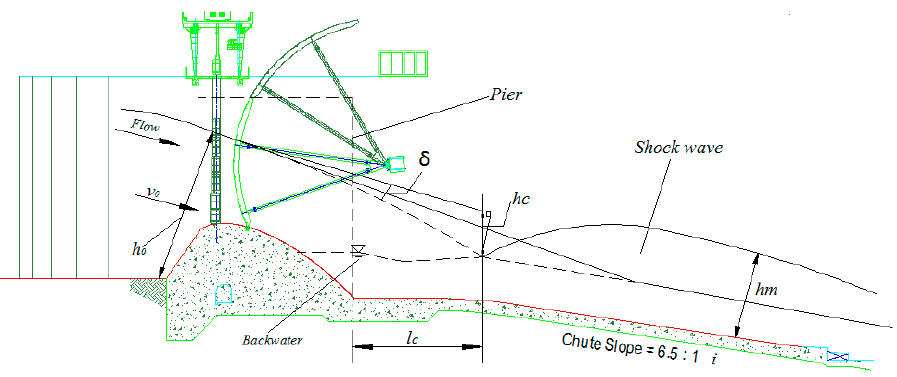
Figure 3. Definition sketch for observed hydraulic parameters.